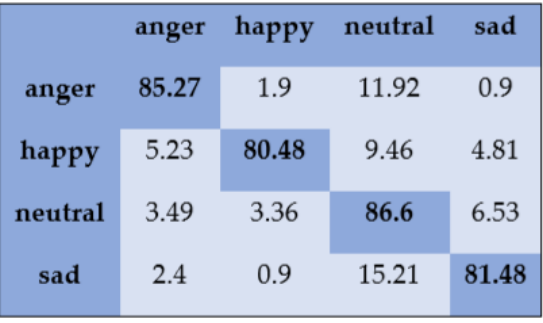
Figure 5. Confusion matrix of IEMOCAP dataset for speaker-dependent SER.